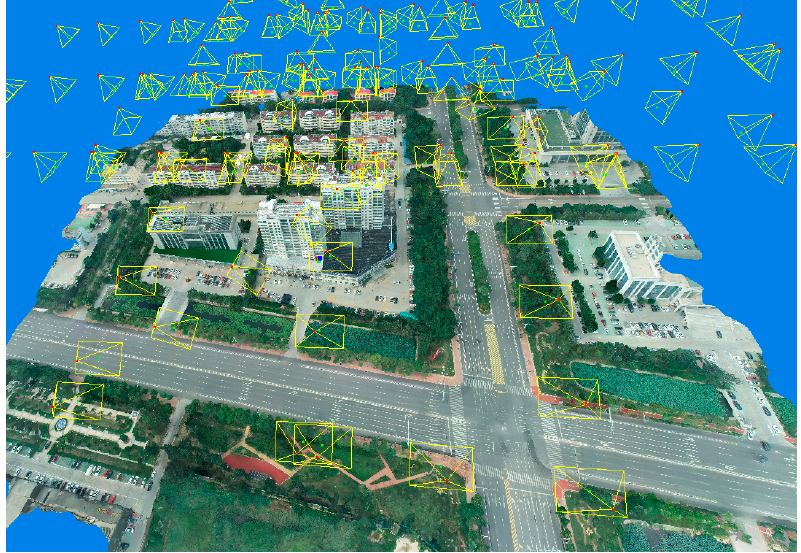
Figure 6. The 3D model and scene structure.